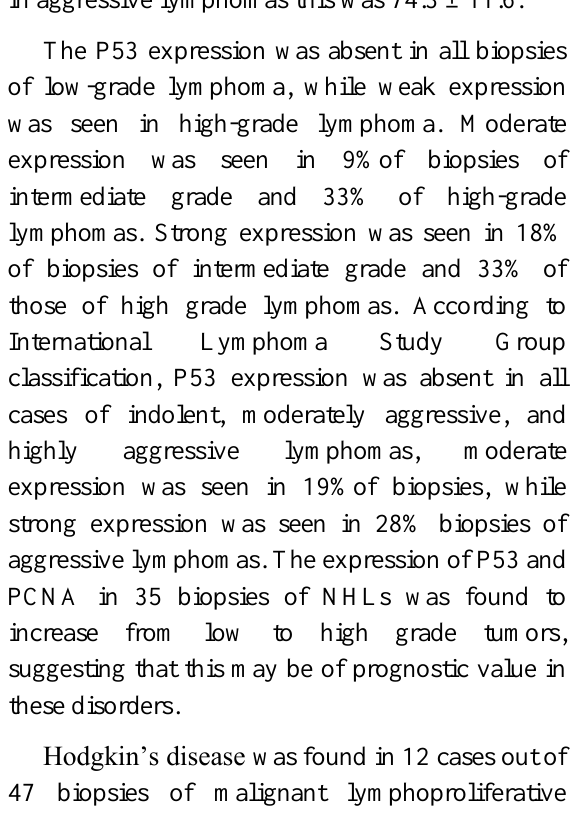
Table 5. Histopathological Typing of Hodgkin’s disease